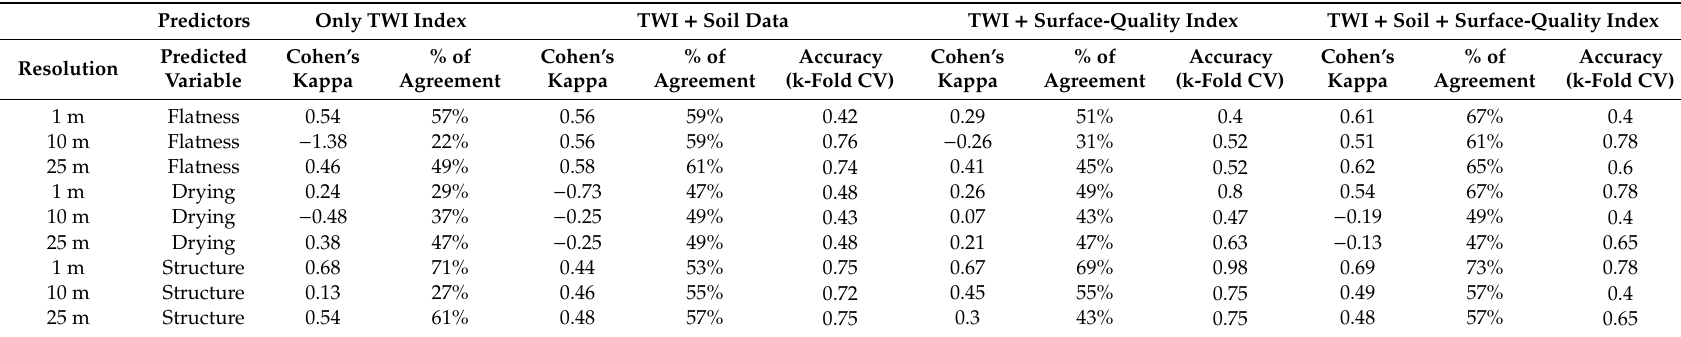
Table 3. Correctness of classification, using three road quality classes (poor, satisfactory and good) and various combinations of predictors, such as the wetness index, soil data and surface-quality index. Cohen’s kappa, the percentage of agreement and the agreement after k-fold (k = 10) cross-validation were calculated.